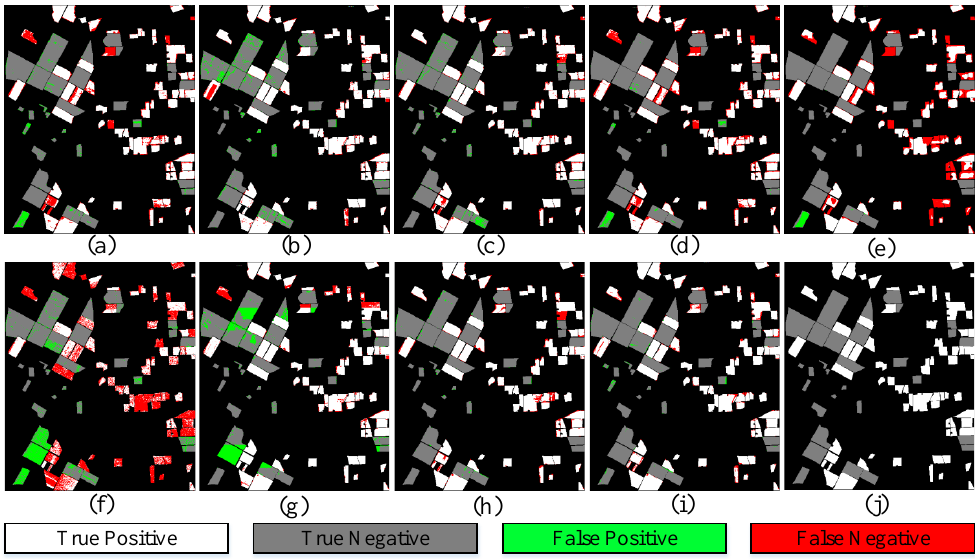
Figure 9. The visual results of different methods on the Bay dataset: ( a ) CVA [61], ( b ) KNN, ( c ) SVM, ( d ) RCVA [39], ( e ) DCVA [50], ( f ) DSFA [51], ( g ) GETNET [6], ( h ) TDSSC [20], ( i ) our ASSCDN, and ( j ) Reference